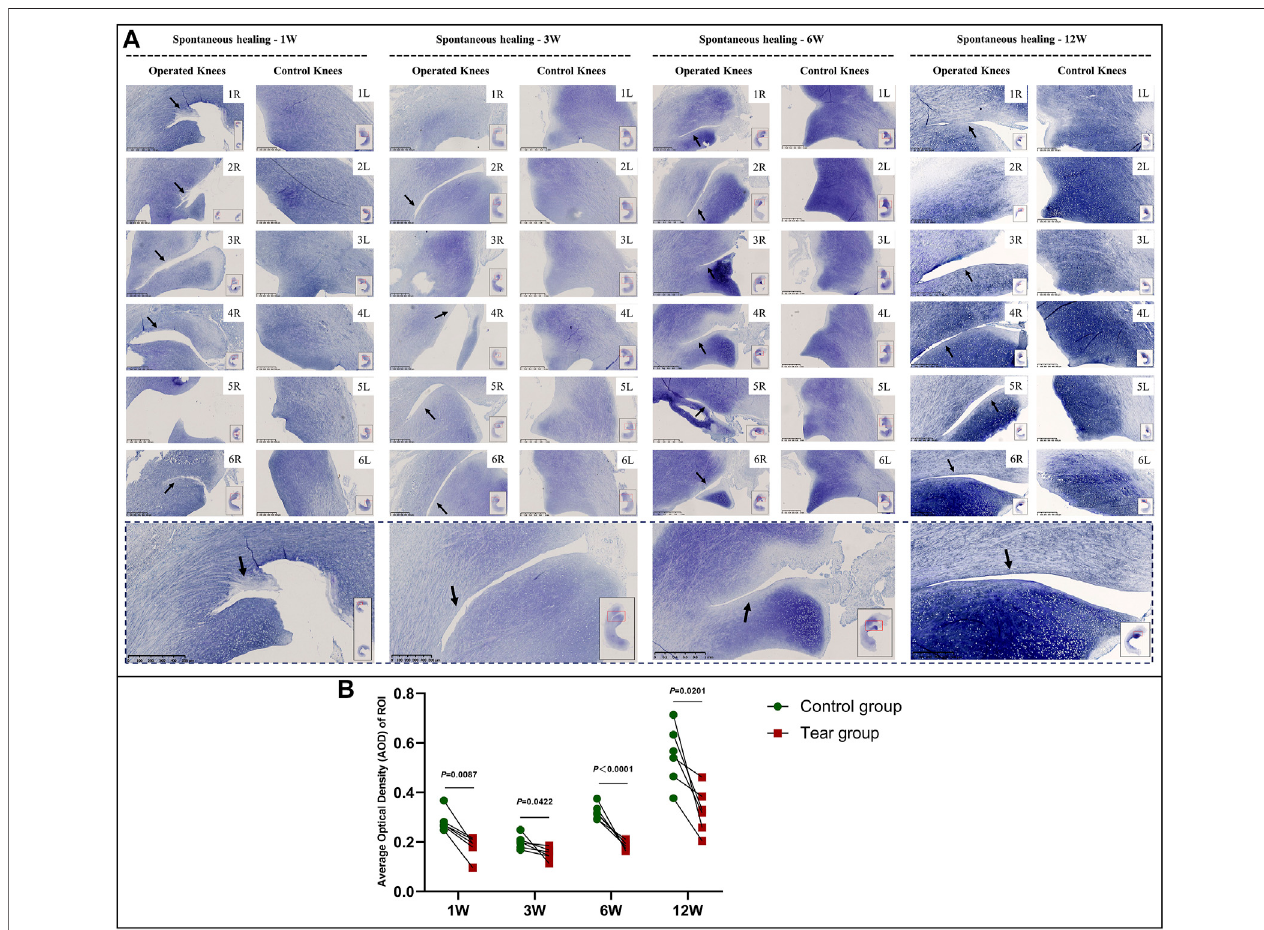
FIGURE6| ToluidinebluestainingandsemiquantitativeevaluationofGAGcontentinimmaturemenisci. (A) Toluidinebluestaining. (B) Semiquantitativeevaluation of GAG content. The black arrows indicate fading of toluidine blue stain. The lower panel of images with a black dotted-line border indicate representative specimens in the corresponding observation period. AOD values are expressed as median values with 95% CIs. n (cid:1) 6.